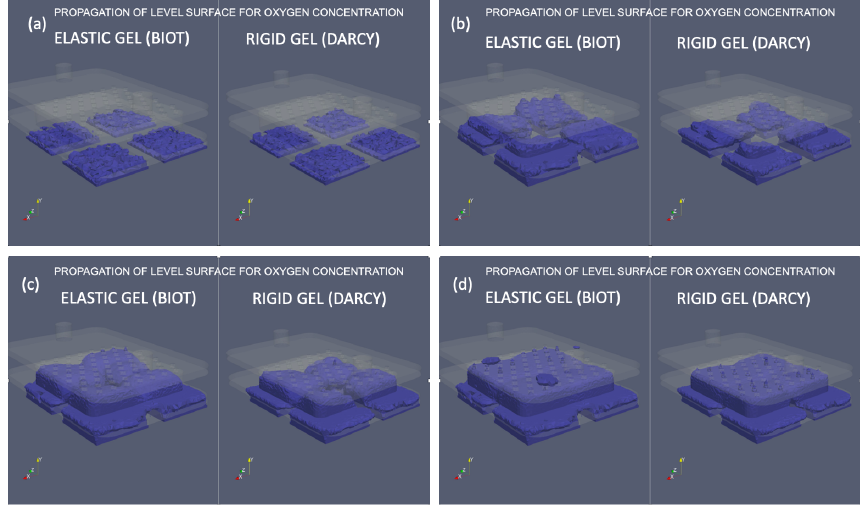
Figure 18. Oxygen front propagation: Comparison between the Biot model (assuming poroelastic hydrogel), and Darcy model (assuming rigid porous hydrogel). The figure shows four snap-shots at increasing times from ( a – d ) showing the propagation of a level surface of oxygen concentration. In figure ( d ) we see that oxygen front has already reached the top gasket in the case of the poroelastic Biot model (figure ( d ) left), while in the case of the rigid gel modeled by Darcy law, the front is still within the islet chamber, not yet reaching the top gasket (figure ( d )